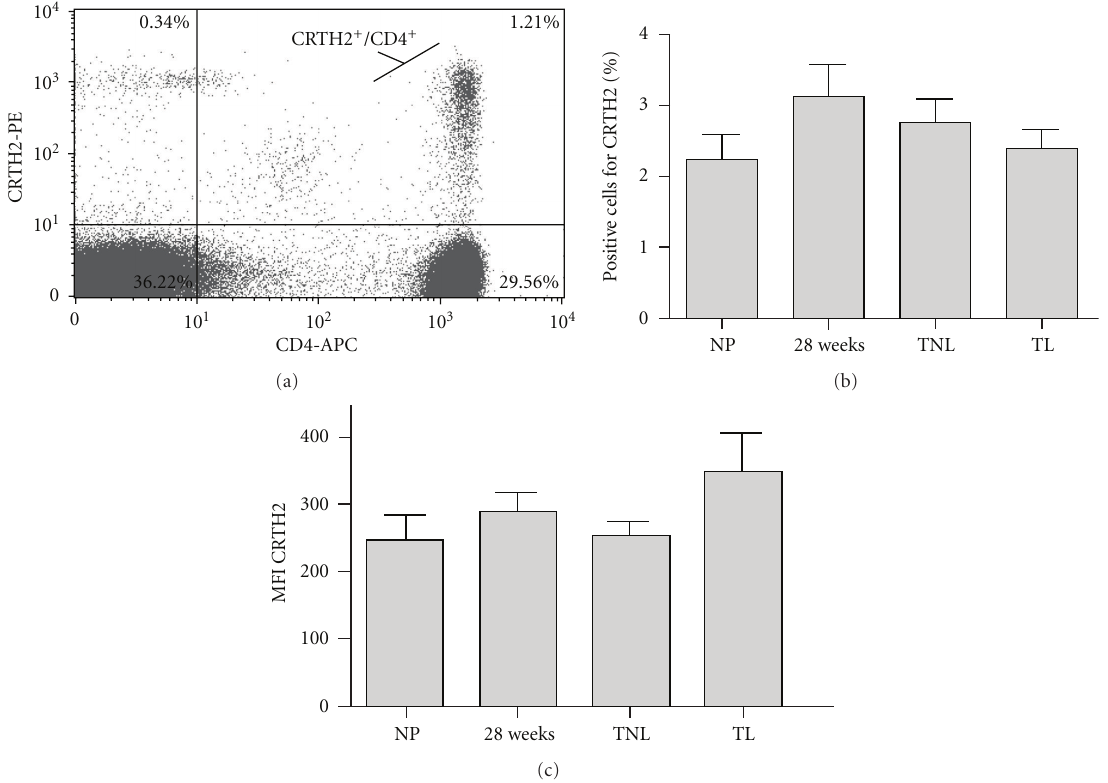
Figure 2: CRTH2 expression in lymphocytes derived from nonpregnant and pregnant subjects. Lymphocytes were gated according to forward scatter and side scatter and T helper cells were identified using CD4 as a cell surface marker ( n = 8 for each group). A representative cytogram from a woman of 28-week gestation is presented with the right upper quadrant showing CRTH2 + /CD4 + lymphocytes (a). The percentage of CRTH2 positive T helper cells (presented as a percentage of positive CD4 positive cells) increased slightly in the third trimester, although statistical significance was not reached (b). No change in mean fluorescence intensity was detected in either the nonpregnant or pregnant samples (c). For statistical analysis ANOVA with Dunnett’s multiple comparison test with NP as a control was